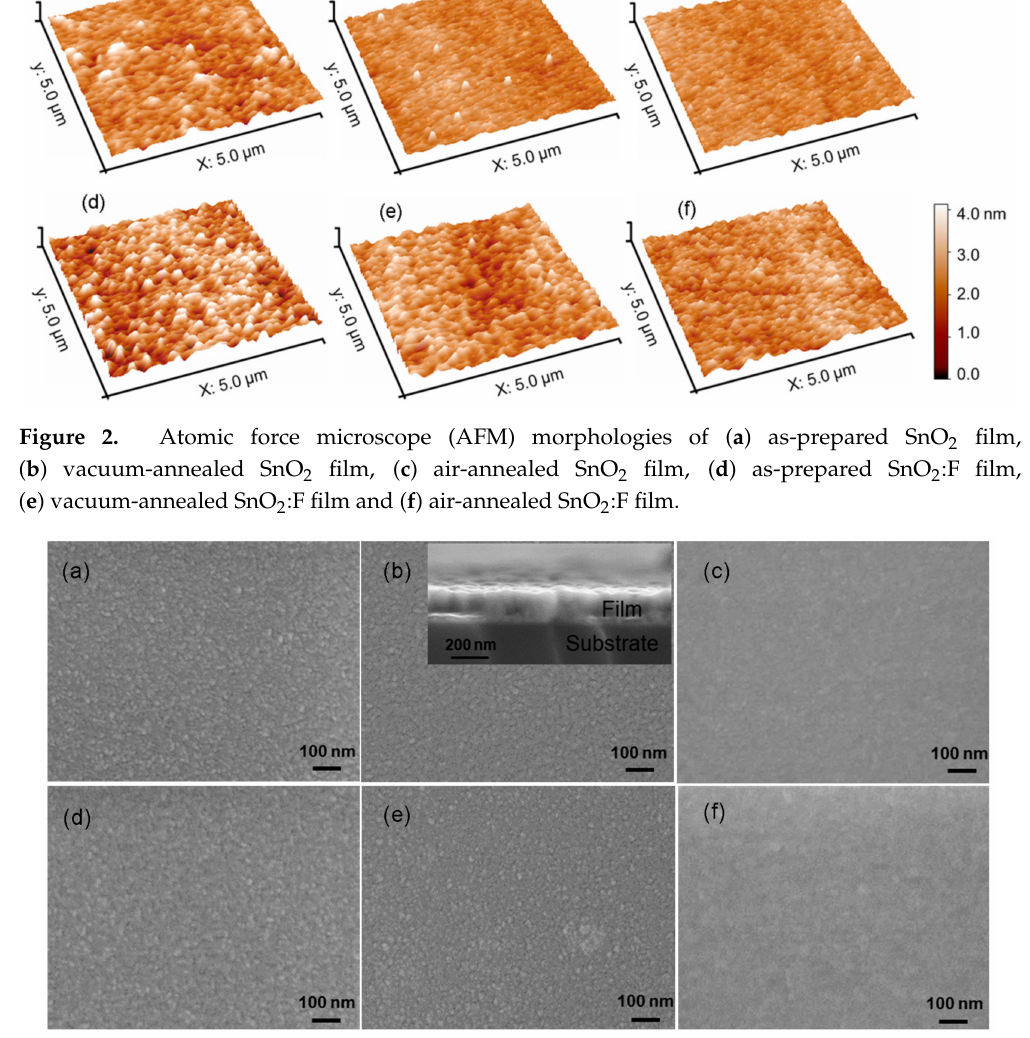
Figure 3. SEM morphologies of ( a ) vacuum-annealed SnO 2 film, ( b ) as-prepared SnO 2 film, ( c ) air-annealed SnO 2 film, ( d ) vacuum-annealed SnO 2 :F film, ( e ) as-prepared SnO 2 :F film and ( f ) air-annealed SnO 2 :F film, and the inset in Figure 3b is a cross-section